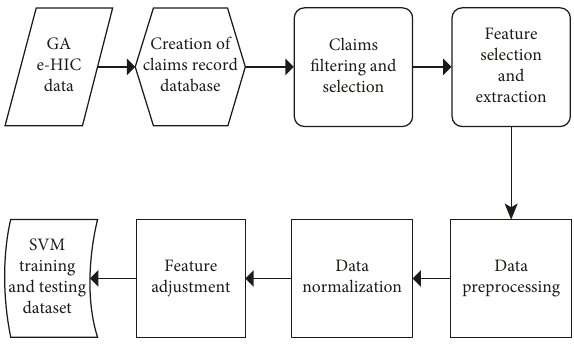
Figure 7: Data preprocessing for SVM training and